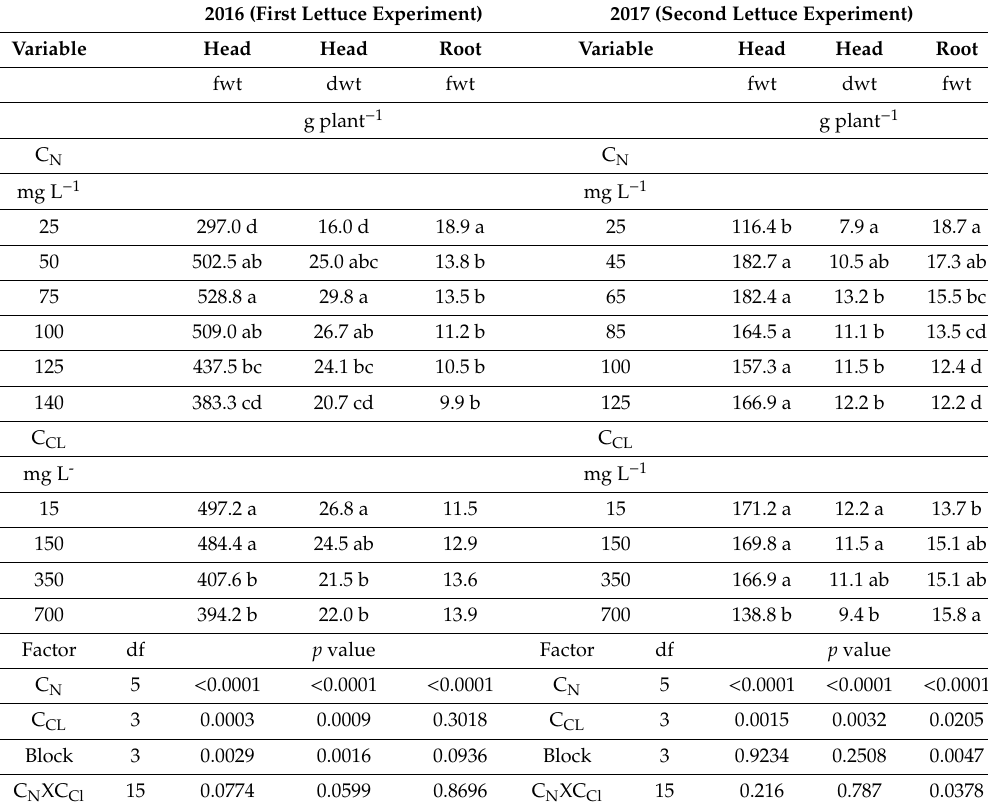
Table 2. The e ff ect of C N and C CL on lettuce head fresh and dry weight and root fresh weight. Probability of F values for C N , C Cl , Block factors, and the interaction of C N and C Cl were determined using the two-way ANOVA procedure of JMP 14. Di ff erent letters on the right side of values indicate significant di ff erence between treatments (HSD) at p < 0.05 by the Tukey–Kramer honestly test. No letters are presented when no significant di ff erence was obtained. 2016 (First Lettuce